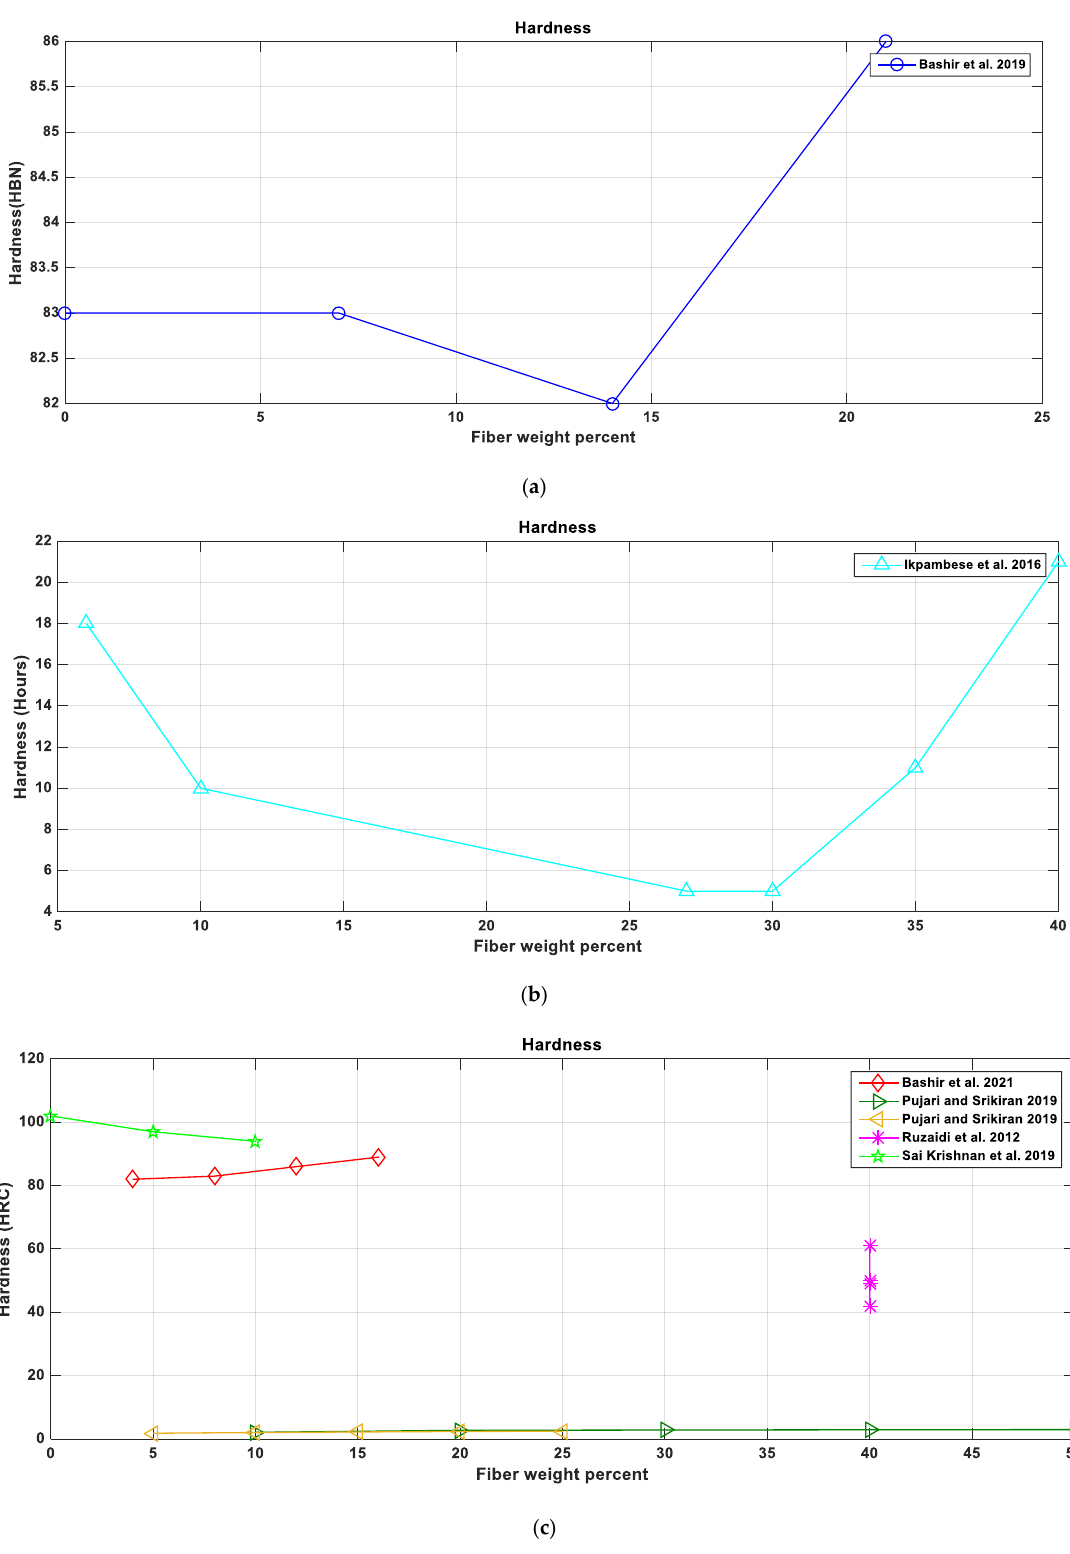
Figure 5. ( a ) The variation of hardness using the Brinell tester for banana fiber with variation in the fiber weight percentage [43], ( b ) illustrates variation of hardness using inertia dynamotor palm kernel fiber with variation in the fiber weight percentage [56], and ( c ) variation of hardness using Rockwell tester for different fibers with a variation in the fiber weight percentage [44,57,62,67].